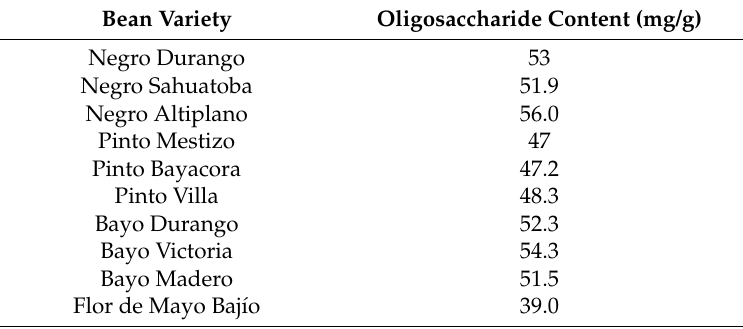
Table 5. Oligosaccharide content on the varieties of the Mexican common